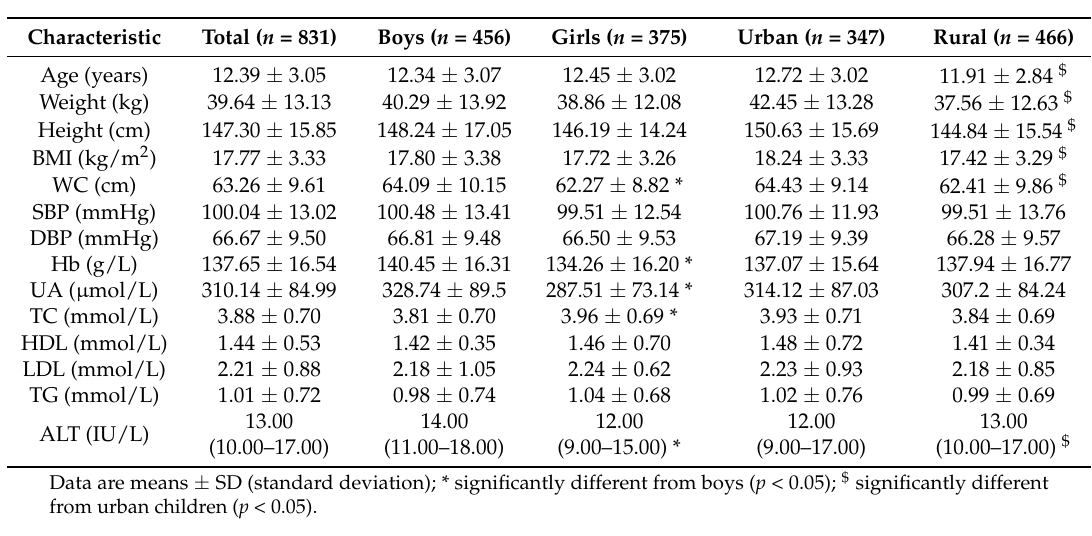
Table 1. Basic characteristics of the children with respect to gender and residence.